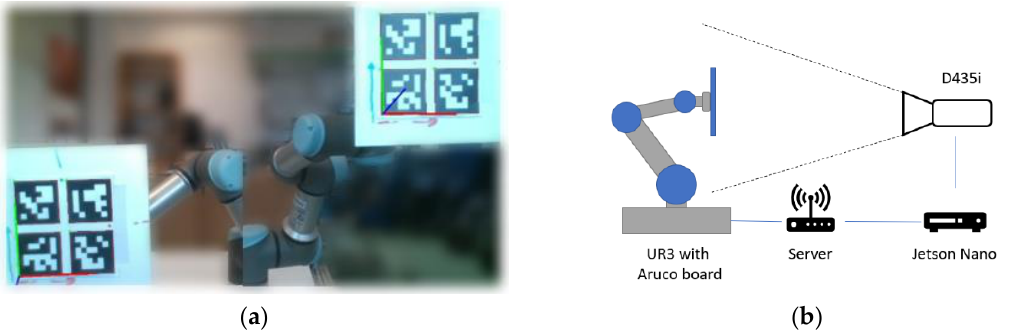
Figure 3. Workplace: ( a ) two measurements at the edge of the measurement range; ( b ) general block diagram.